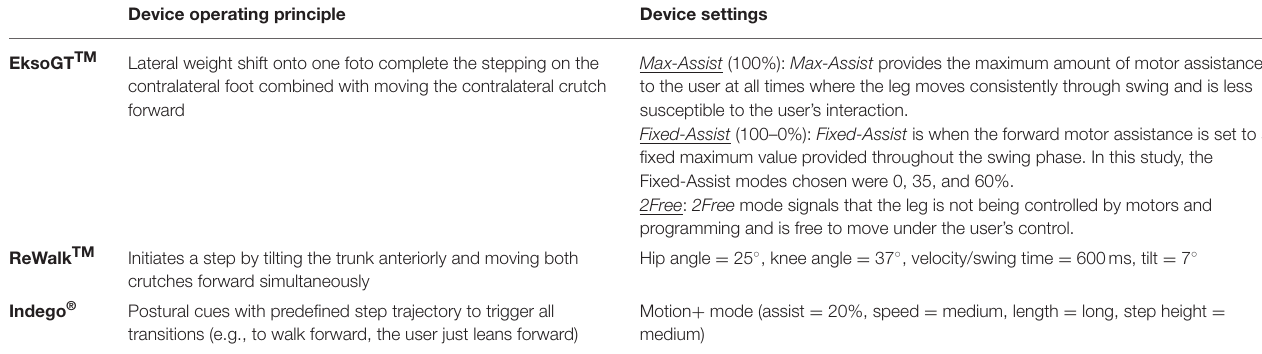
TABLE 2 | Robotic exoskeleton operating principle and